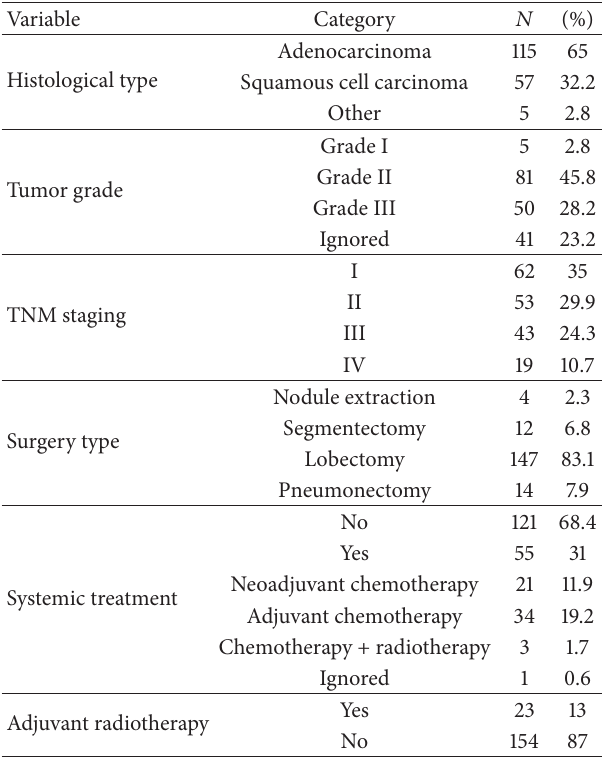
Table 2: Clinical